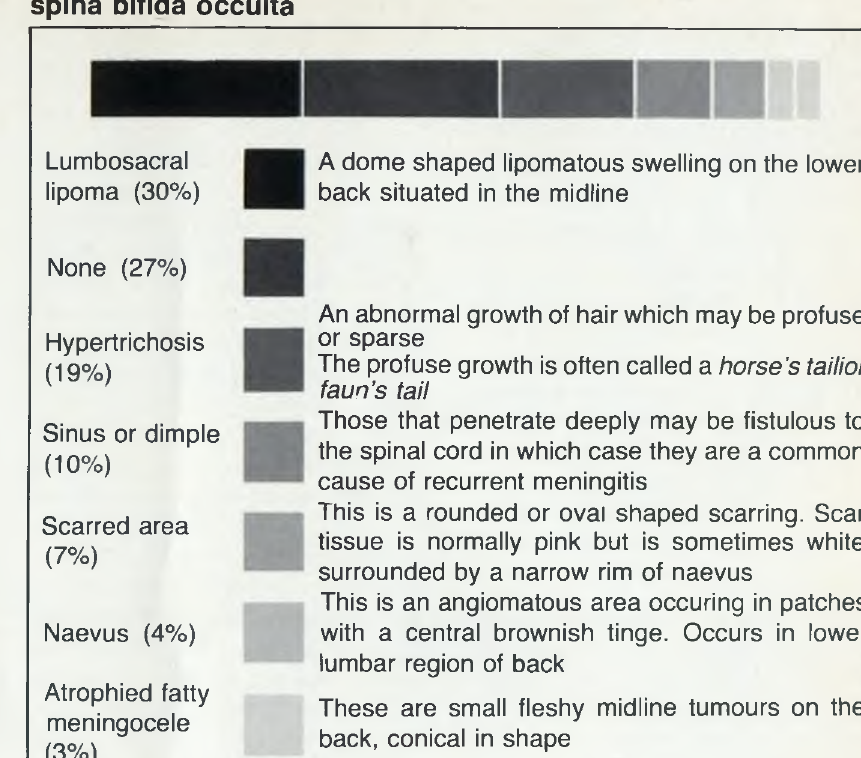
Fig 4: Ventriculo-caval and ventriculo-peritoneal